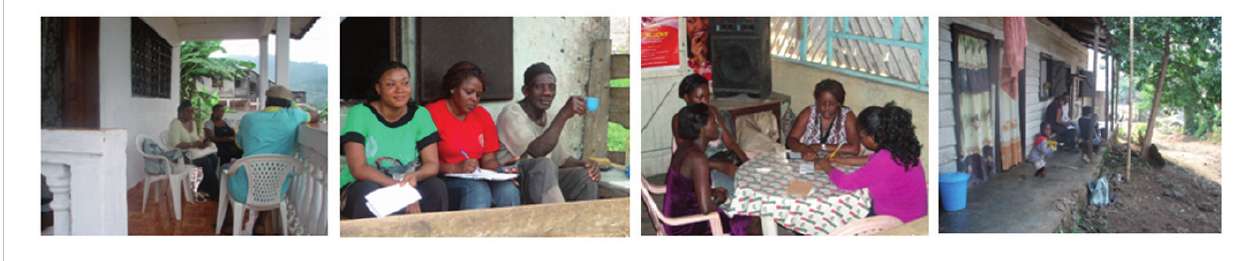
Figure 10. Philological approach to interviews and questionnaires in the framework of the FP7 MIA-VITA Project during the fieldwork campaigns in the Fako division [Pannaccione Apa et al.